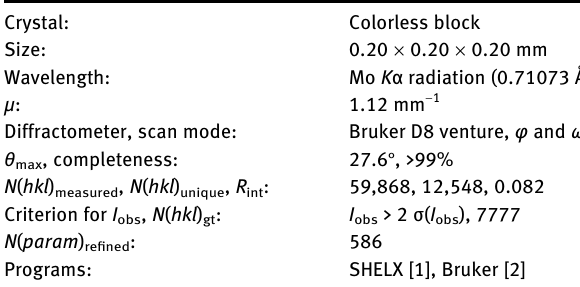
Table  : Data collection and